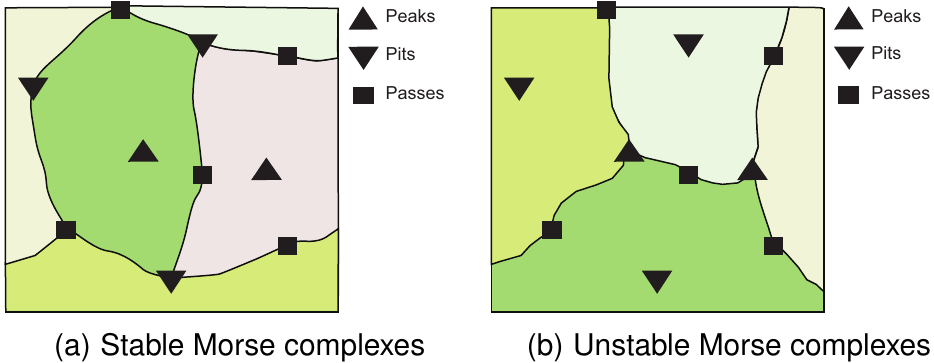
Figure 3. Stable/Unstable Morse complexes. This figure is adapted from